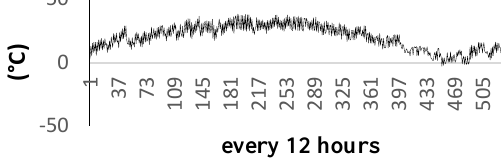
Figure 9 .Relative Humidity for every 12 ℎ in 2012